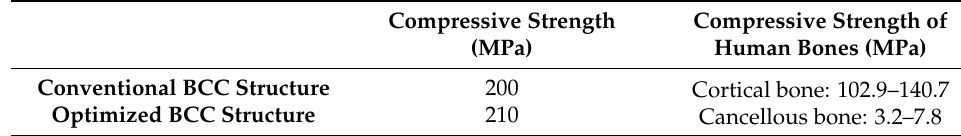
Table 4. Comparison of compressive strength of two structures.